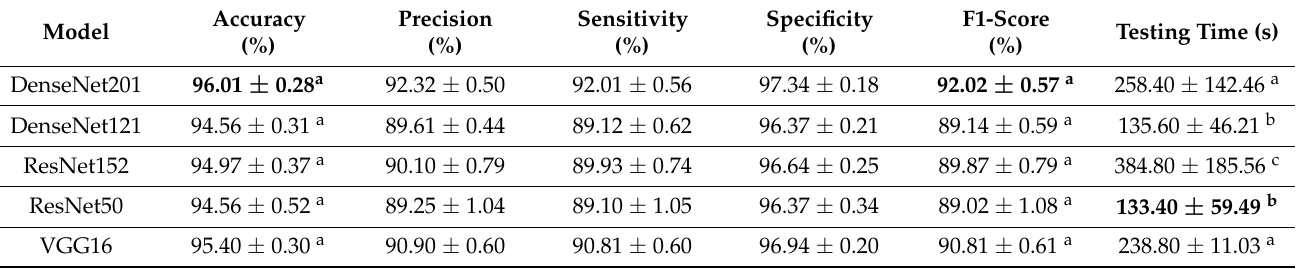
Table 6. Performance of each pre-trained models using Adam